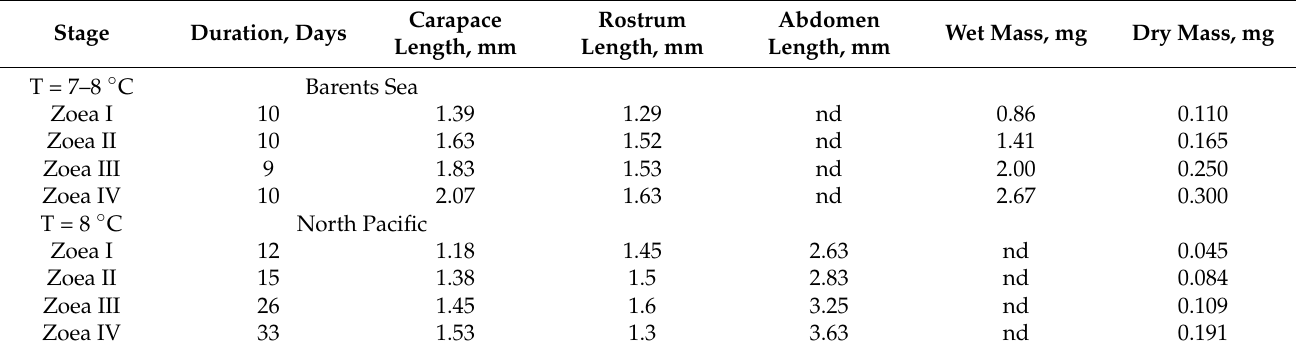
Table 1. Morphology, growth, development, and mass of zoeal stages of red king crab from the Barents Sea and North Pacific [73–76].